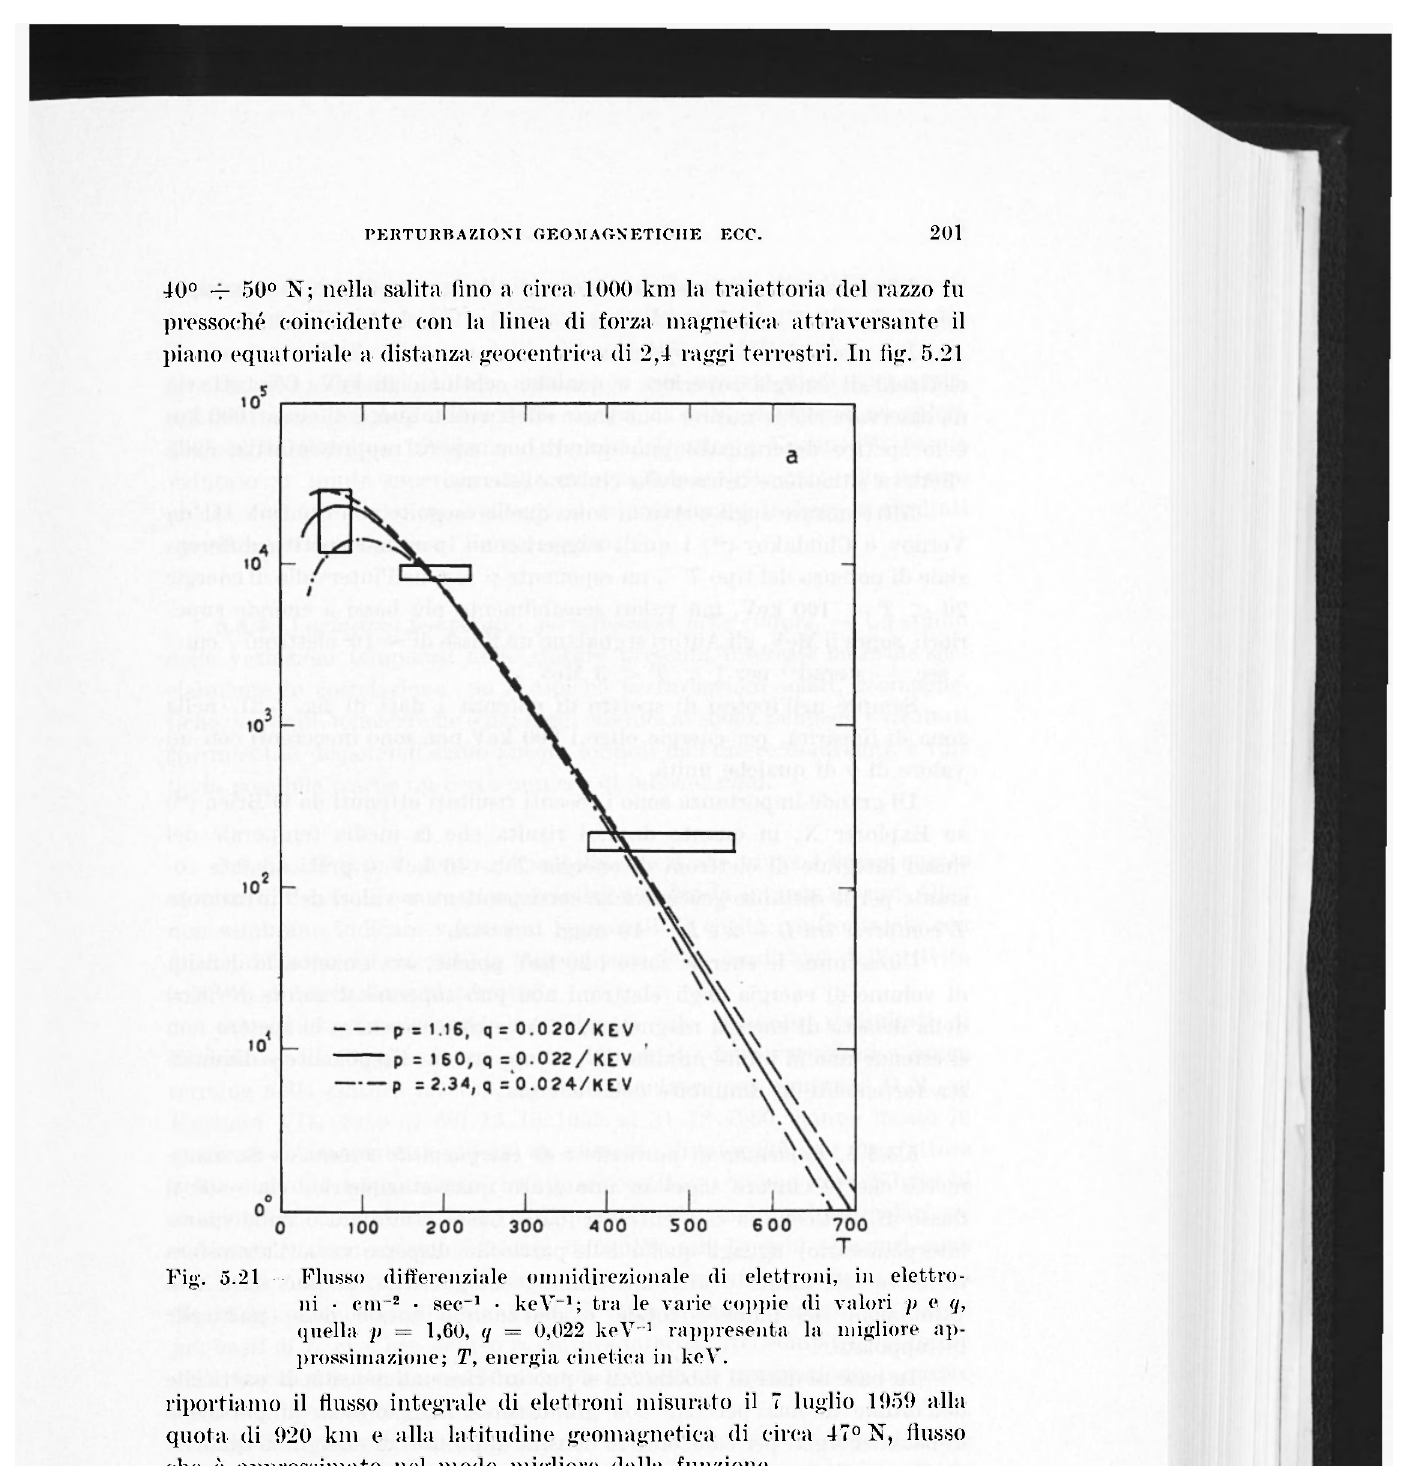
Fig-, 5.21 Flusso differenziale omnidirezionale di elettroni, in elettro- ni • c n r ! • sec -1 • keV -1 ; tra le varie coppie di valori p e q, quella p = 1,60, q = 0,022 keV" 1 rappresenta la migliore ap- prossimazione; T, energia cinetica in keV.